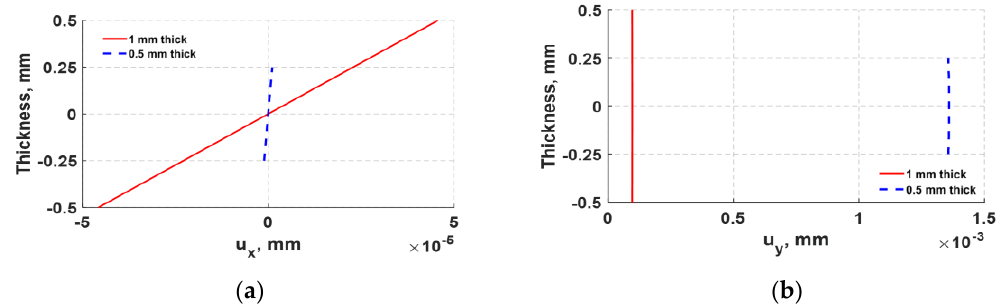
Figure 12. Comparison of through-PZT thickness displacements for a 1 mm actuator (red solid line) and 0.5 mm actuator (blue dashed line) excited with a five-peak tone burst signal at 30 kHz. ( a ) Axial (x) displacement; ( b ) lateral (y) displacement.